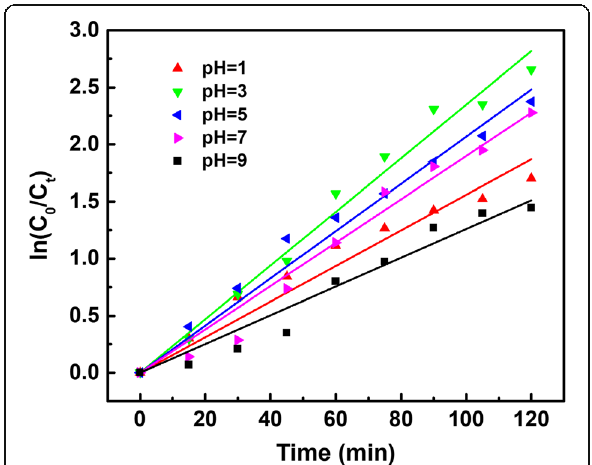
Fig. 4 The effect of different pH on TBBPA degradation efficiency in photoelectrocatalytic process under simulated daylight irradiation. The geometric surface area of TiO 2 electrode was 2.0 × 2.5 cm 2 . Initial concentration of TBBPA: 10 mg L − 1 , volume: 50 mL, electrolyte: 0.05 M Na 2 SO 4 , bias potential: 9